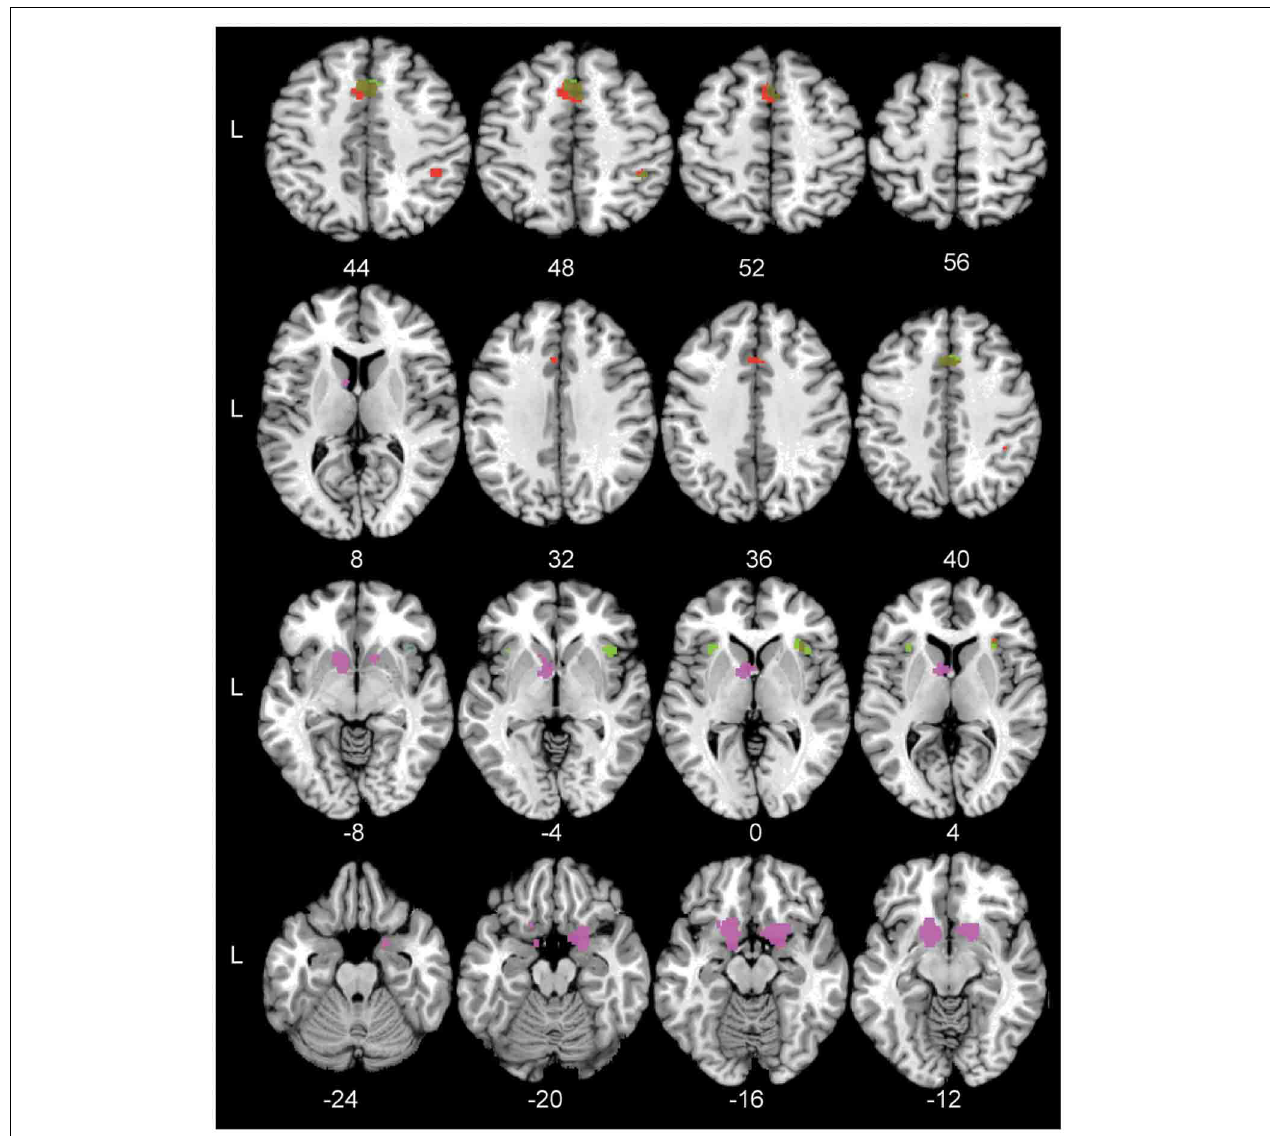
FIGURE 3 | The significant conjunction and subtraction clusters in standard Montreal Neurological Institute space. Green: The significant conjunction clusters for the task-general network and the task difficulty network are located in the right pre-SMA, left pre-motor cortex, bilateral anterior insula, and right PFm. Blue: The significant conjunction cluster for the task-general and reward networks is located